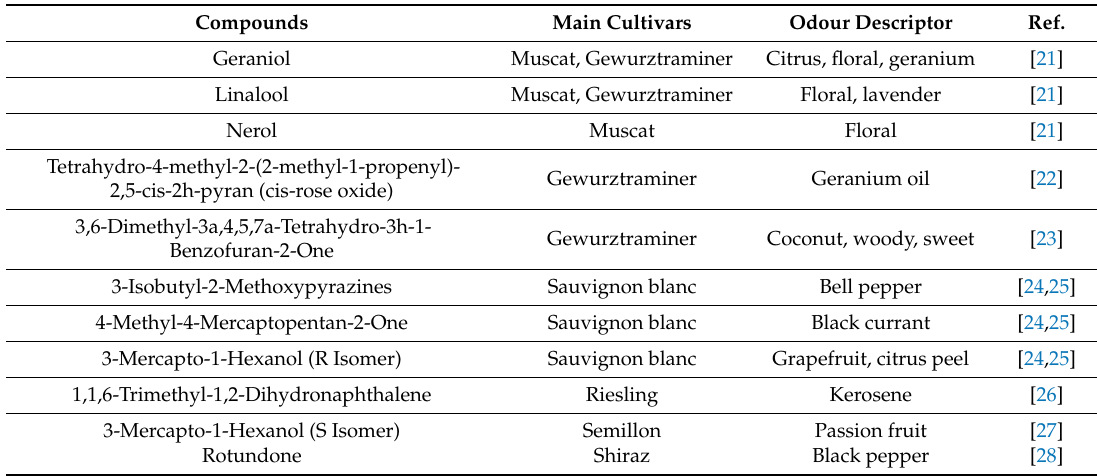
Table 1. Main odorants contributing to varietal aromas of some monovarietal wines.